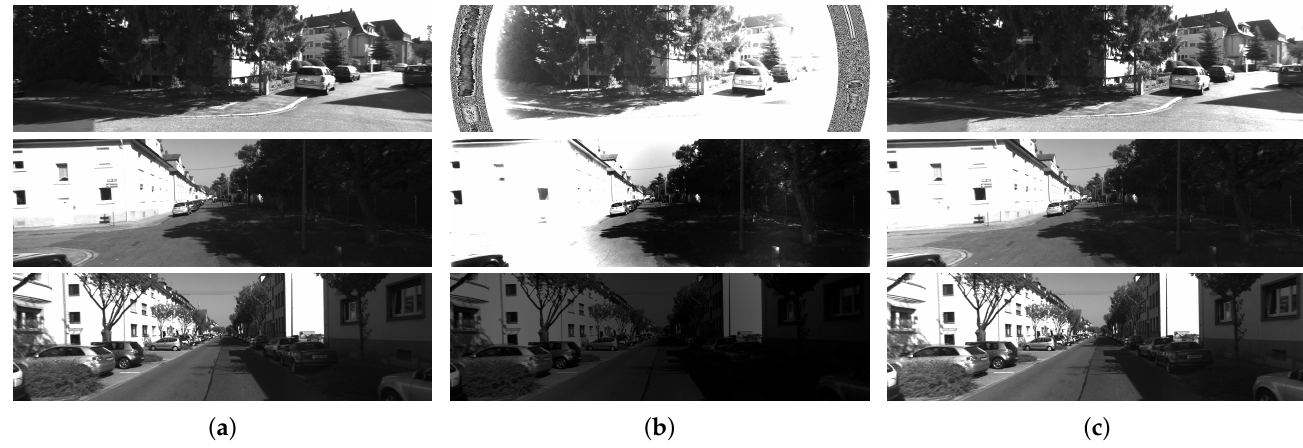
Figure 3. The experimental results of KITTI dataset 00 sequences. ( a ) The original images of KITTI 00 sequences. ( b ) Cor- rected images by Reference [11]. ( c ) Corrected images by our method.